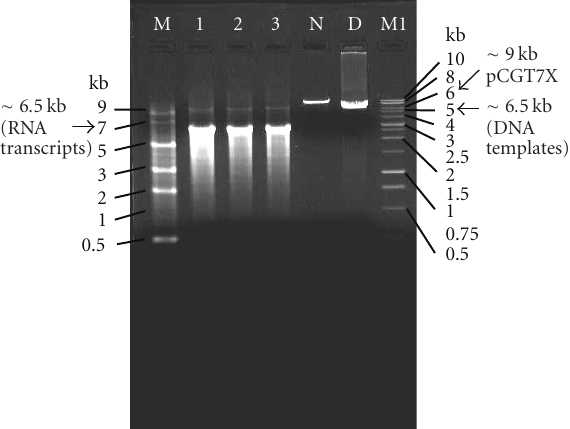
Figure 2: A representative gel image of pCG+FSRTRE-derived transcripts without DNase I treatment electrophoresed after denat- uration showing the expected transcript size (6.5 kb). The band above the transcript band is the DNA template. Lane M: RNA marker (Invitrogen, Calif, USA); 1, 2, 3: produced transcripts; M1: 1kb DNA ladder (Promega, Wis, USA); N: pCGT7X, ∼ 9.0 kb; D: DNA template, ∼ 6.5 kb. There were traces of DNA template detected in transcripts without DNase I